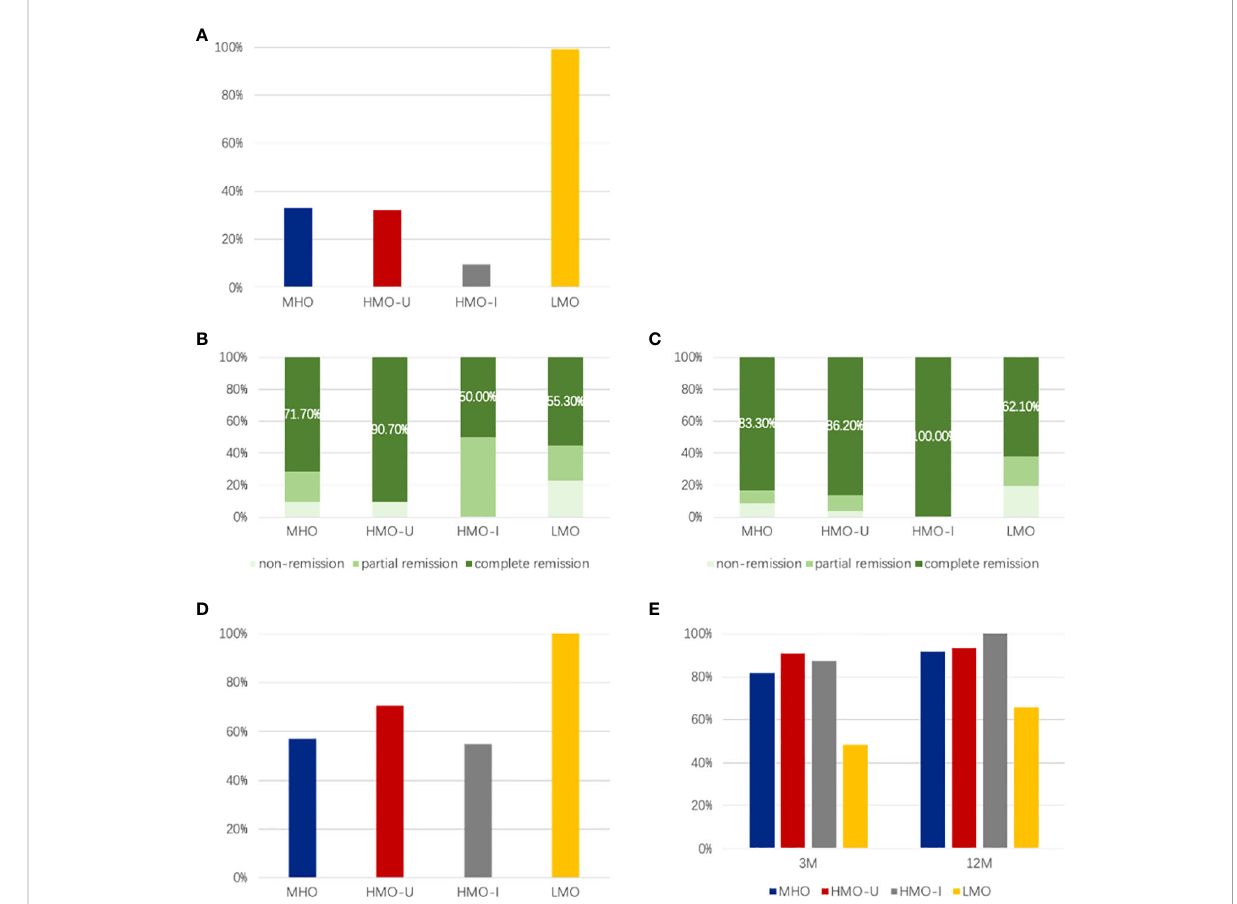
FIGURE 2 Comparison of different AIM subgroups of obesity for the rate of diabetes and hyperglycemia pre-surgery and corresponding remission rate at 3- and 12-month post-surgery. (A) Rate of diabetes pre-surgery; (B, C) Remission rate at 3-month (B) and 12-month (C) post-surgery; (D) Rate of hyperglycemia pre-surgery; E, Remission rate of hyperglycemia at 3- and 12-month post-surgery. MHO, metabolic healthy obesity; HMO-I, hypermetabolic obesity hyperinsulinemia subtype; HMO-U, hypermetabolic obesity hyperuricemia subtype; LMO, hypometabolic obesity; NW, normal-weight